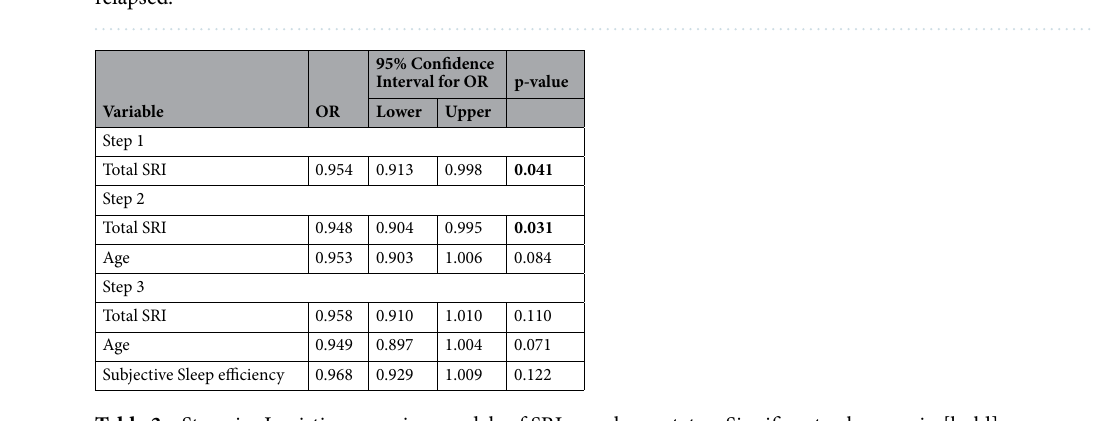
Table 3. Stepwise Logistic regression models of SRI on relapse status. Significant values are in [bold].